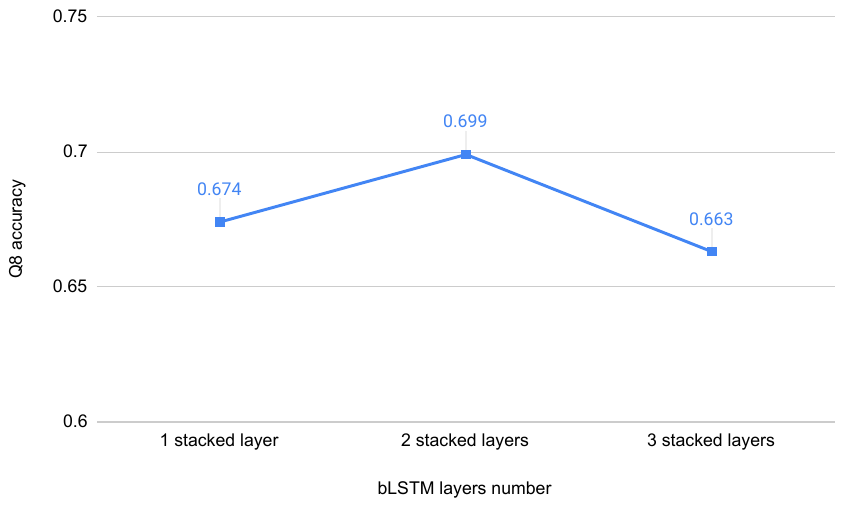
Figure 6. Q8 accuracy of bLSTM on cb513 dataset with different number of LSTM layers.